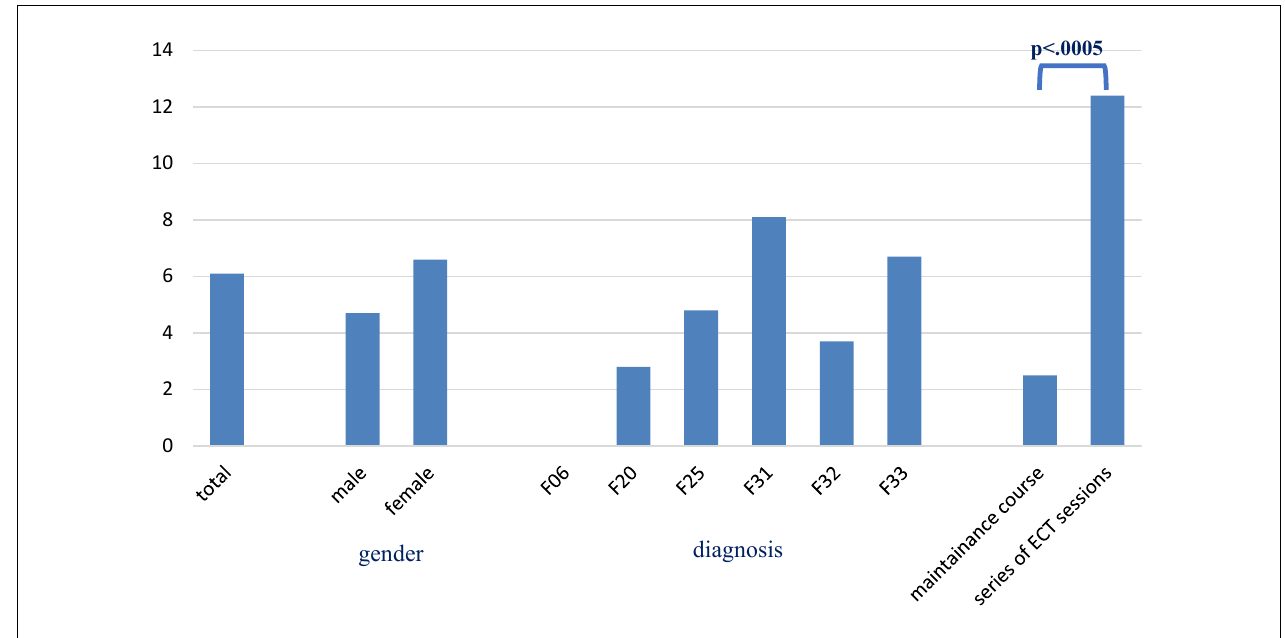
FIGURE 1 | Percentage of patients experiencing mild adverse events ( n = 641 cases = hospital